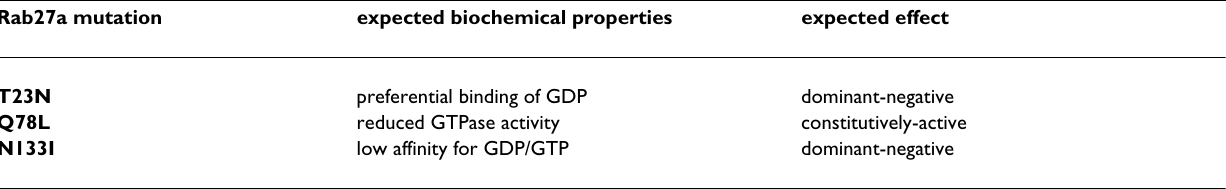
Table 1: Mutations affecting the GTP/GDP cycle of Rab27a Rab27a mutation